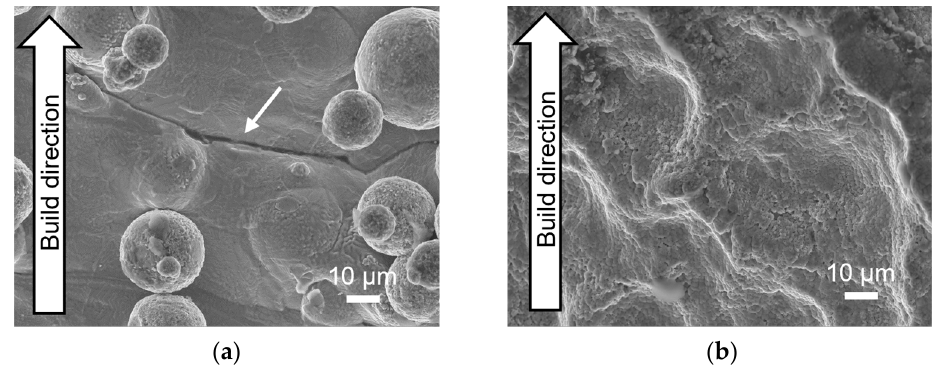
Figure 9. Aspects of specimen surfaces observed by scanning electron microscope: ( a ) as-built specimen; ( b ) specimen treated with laser cavitation.